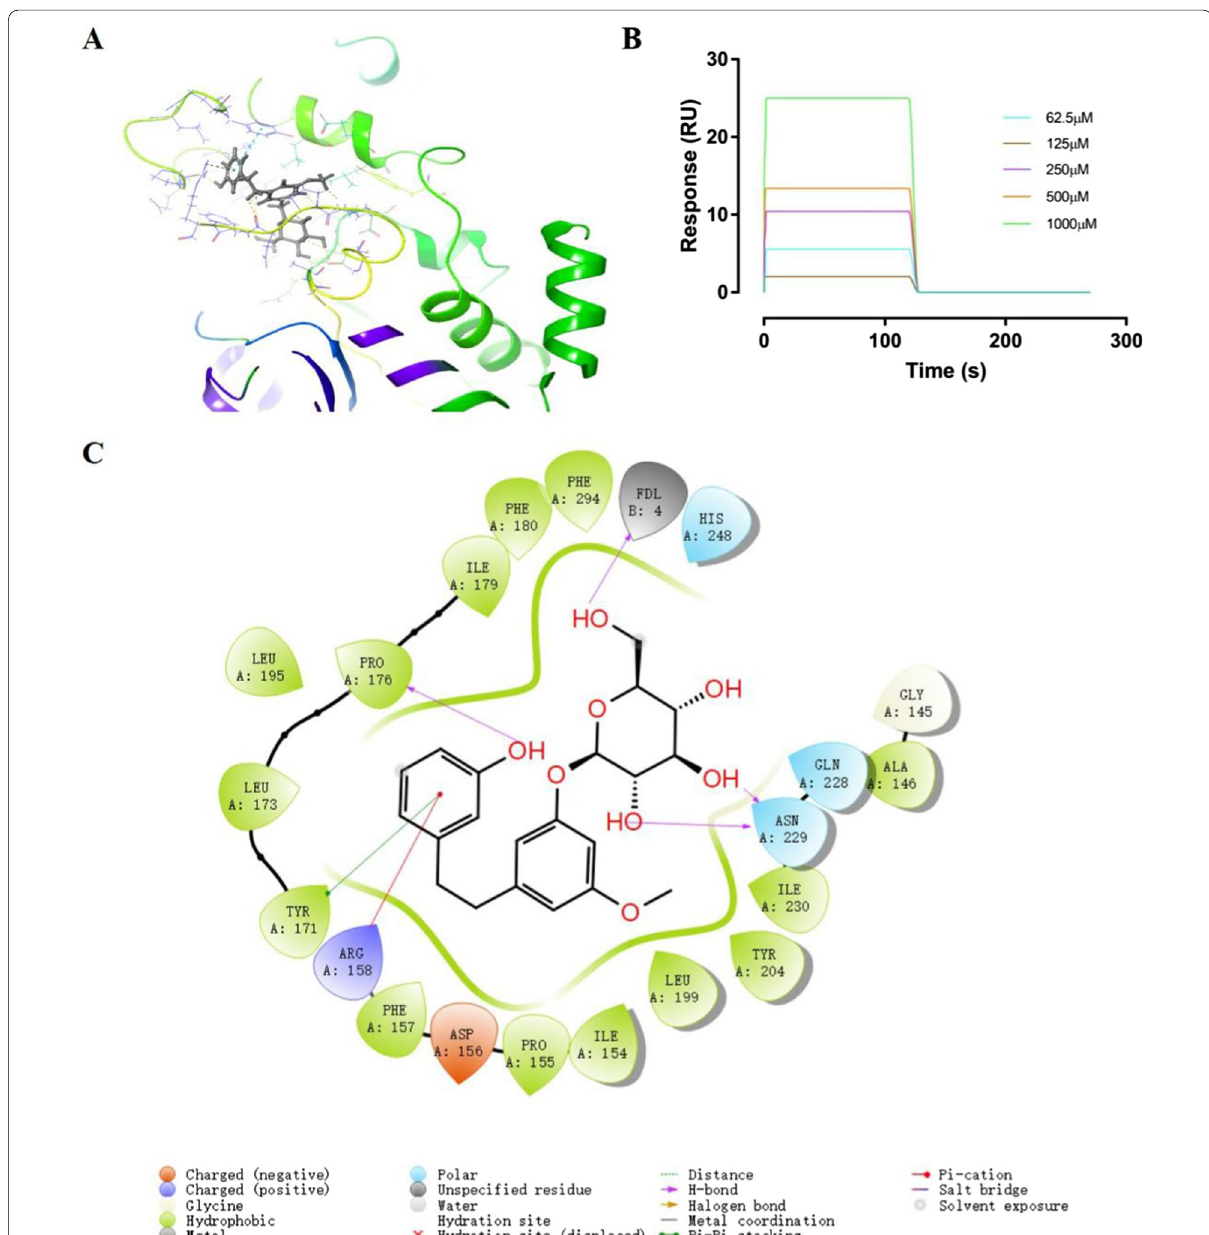
Fig. 1 Interactions between bibenzyl derivatives in D. officinale and SIRT3 protein. The following is an example of compound 6 (C6). A C6 bound to SIRT3 protein at a suitable binding pocket predicted by molecular docking. B Sensorgram of C6 at various concentrations (62.5, 125, 250, 500 and 1000 μM) binding to SIRT3 protein. C Receptor‑based molecular docking protein–ligands interactions profile of SIRT3 protein with